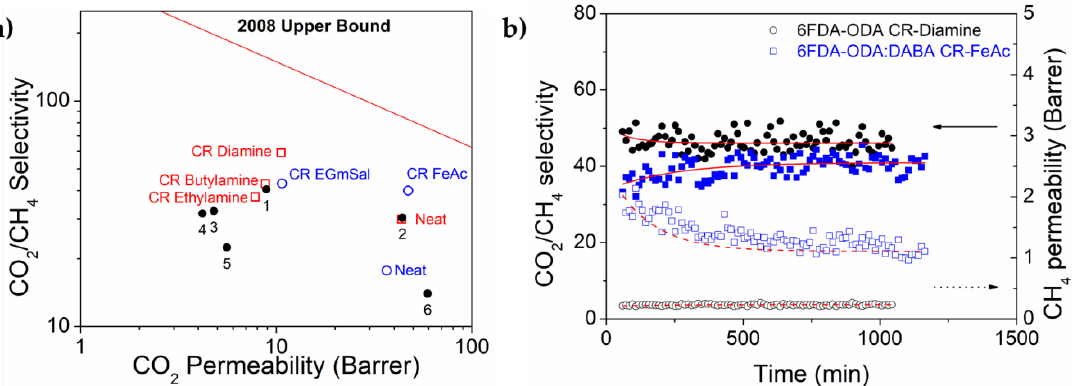
Figure 9. ( a ) The CO 2 /CH 4 separation performance of neat 6FDA-ODA and its crosslinked membranes using (1) m -xylylene diamine; (2) n -ethylamine; (3) n -butylamine; neat 6FDA-ODA:DABA (8:2) and its crosslinked membranes with (i) EGmSal; (ii) FeAc, against the 2008 Robeson plot [4]. Also in comparison to several industrially relevant polymer membranes (numbered 1–6) for gas separation, as highlighted by Sanders et al. [41]; ( b ) The selectivity and CH 4 permeability performances of 6FDA-ODA CR-diamine and 6FDA-ODA:DABA CR-FeAc, when tested with 50:50 CO 2 :CH 4 feed mixture at 8 bar, at a constant temperature of 25 °C over time.